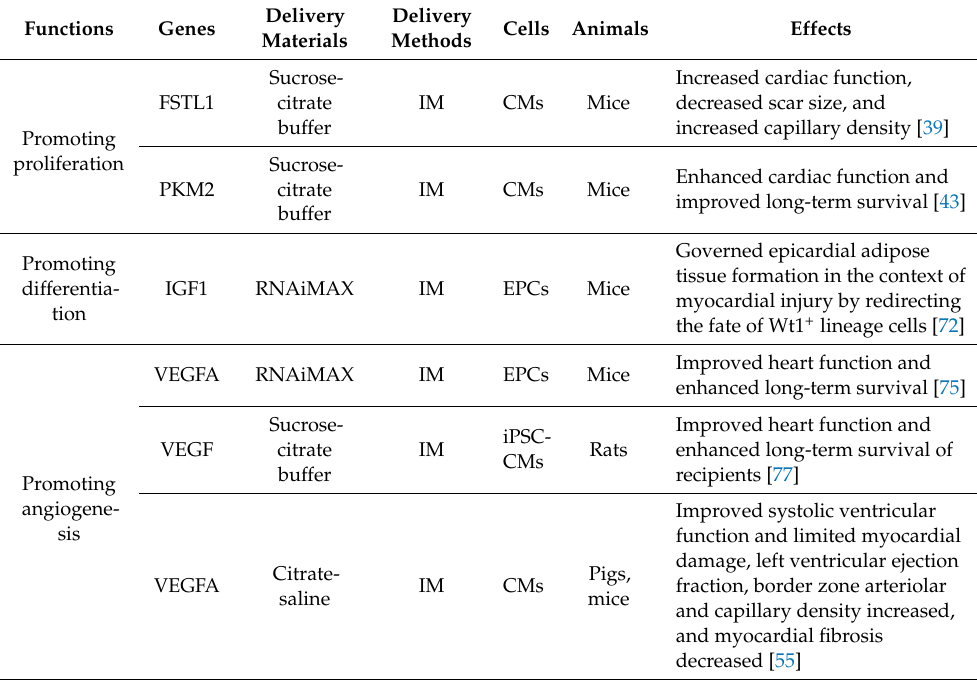
Table 1. Mechanisms of the modRNA therapeutic strategy for MI